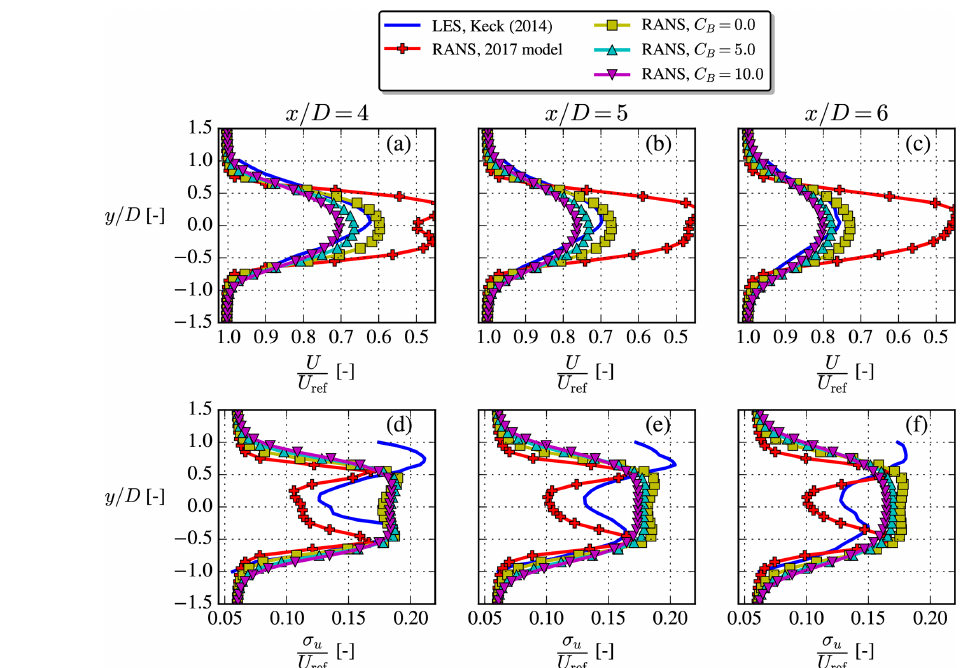
Figure 13. The unstable V80-Keck case, where LES results were digitized from Keck et al. (2014). Profiles extracted at z = z ref . Note that streamwise TI (d–f) is based on U ref and σ u ≈